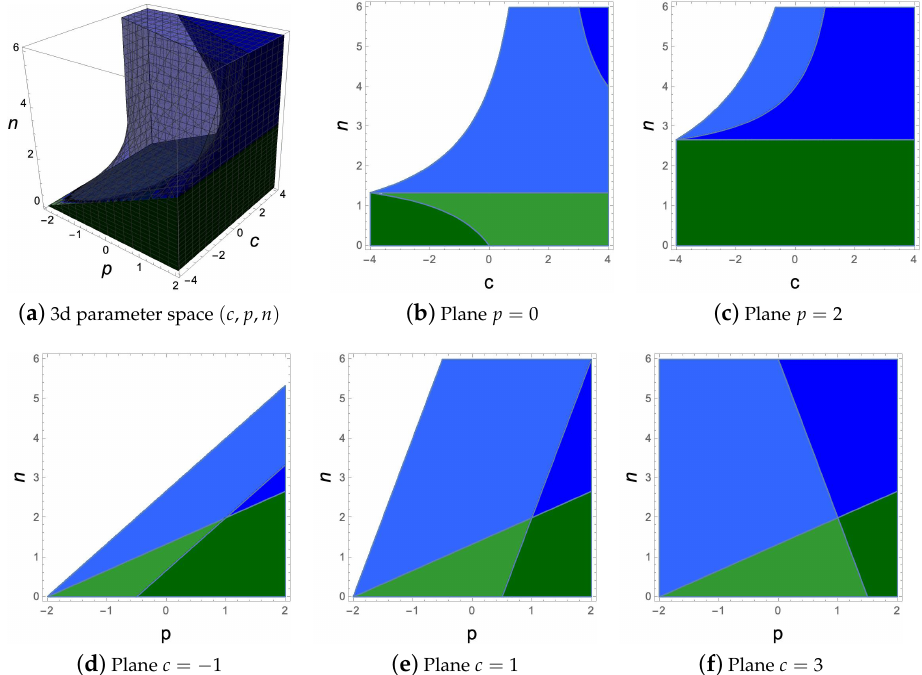
Figure 2. The parameter space of WI in the strong dissipative regime ( Q > 1) and for the monomial class of inflaton potentials. The shaded areas are classified based on the behavior of Q , T / H , and T during inflation when all three increase (light green), Q decreases and both T / H and T increase (dark green), T decreases and both Q and T / H increase (light blue), and T / H increases and both Q and T decrease (dark blue). Figure based on